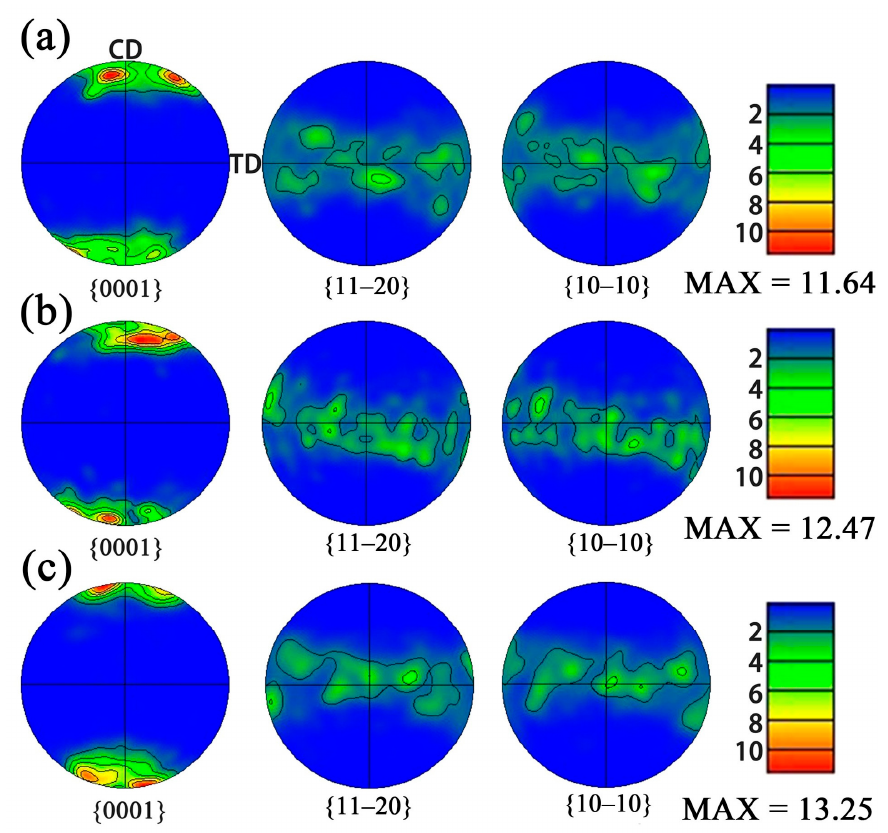
Figure 15. Pole figures of Mg-3Bi alloy at various deformation conditions: ( a ) 573 K and 0.01 s − 1 , ( b ) 623 K and 0.01 s − 1 , ( c ) 573 K and 0.1 s − 1 . ( b ) 623 K and 0.01 s − 1 , ( c ) 573 K and 0.1 s − 1